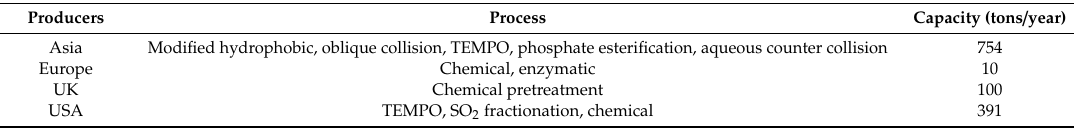
Table 2. World production of cellulose nanofibrils, 2018 (per producer).